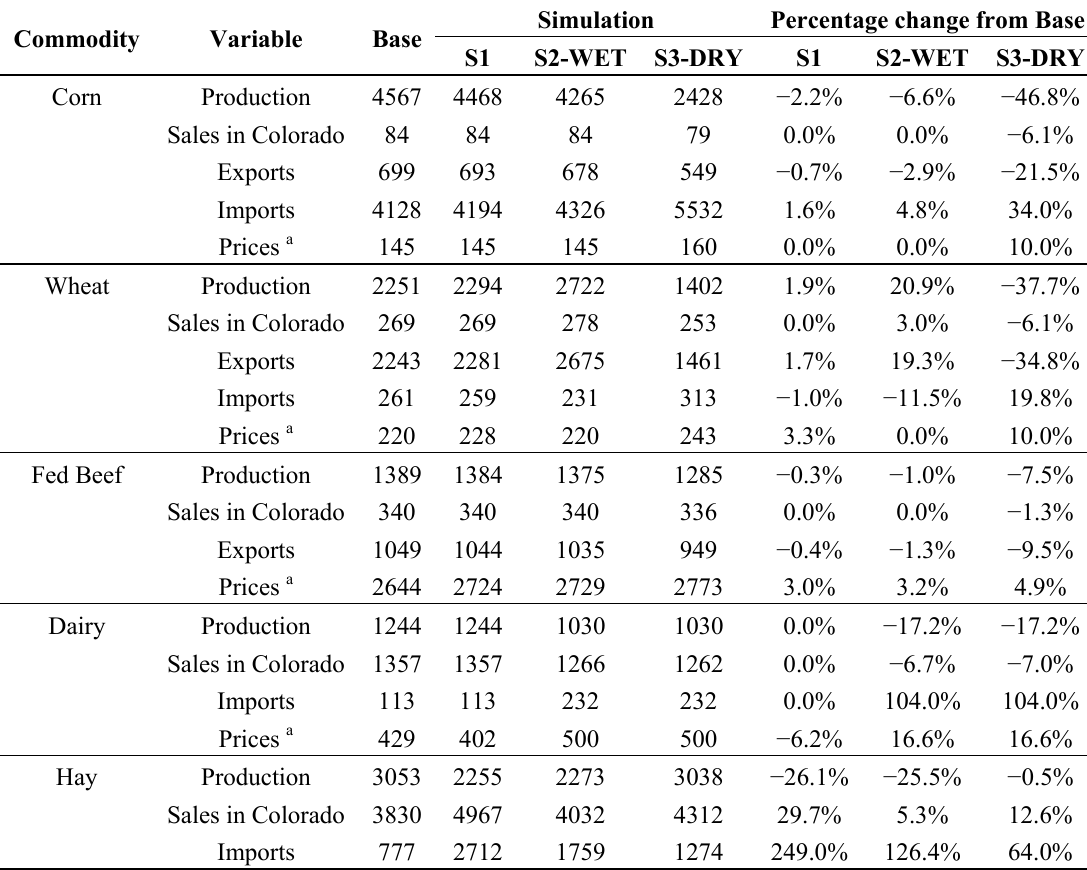
Table 4. Production, sales, exports, imports, and prices in the base and simulation scenarios.